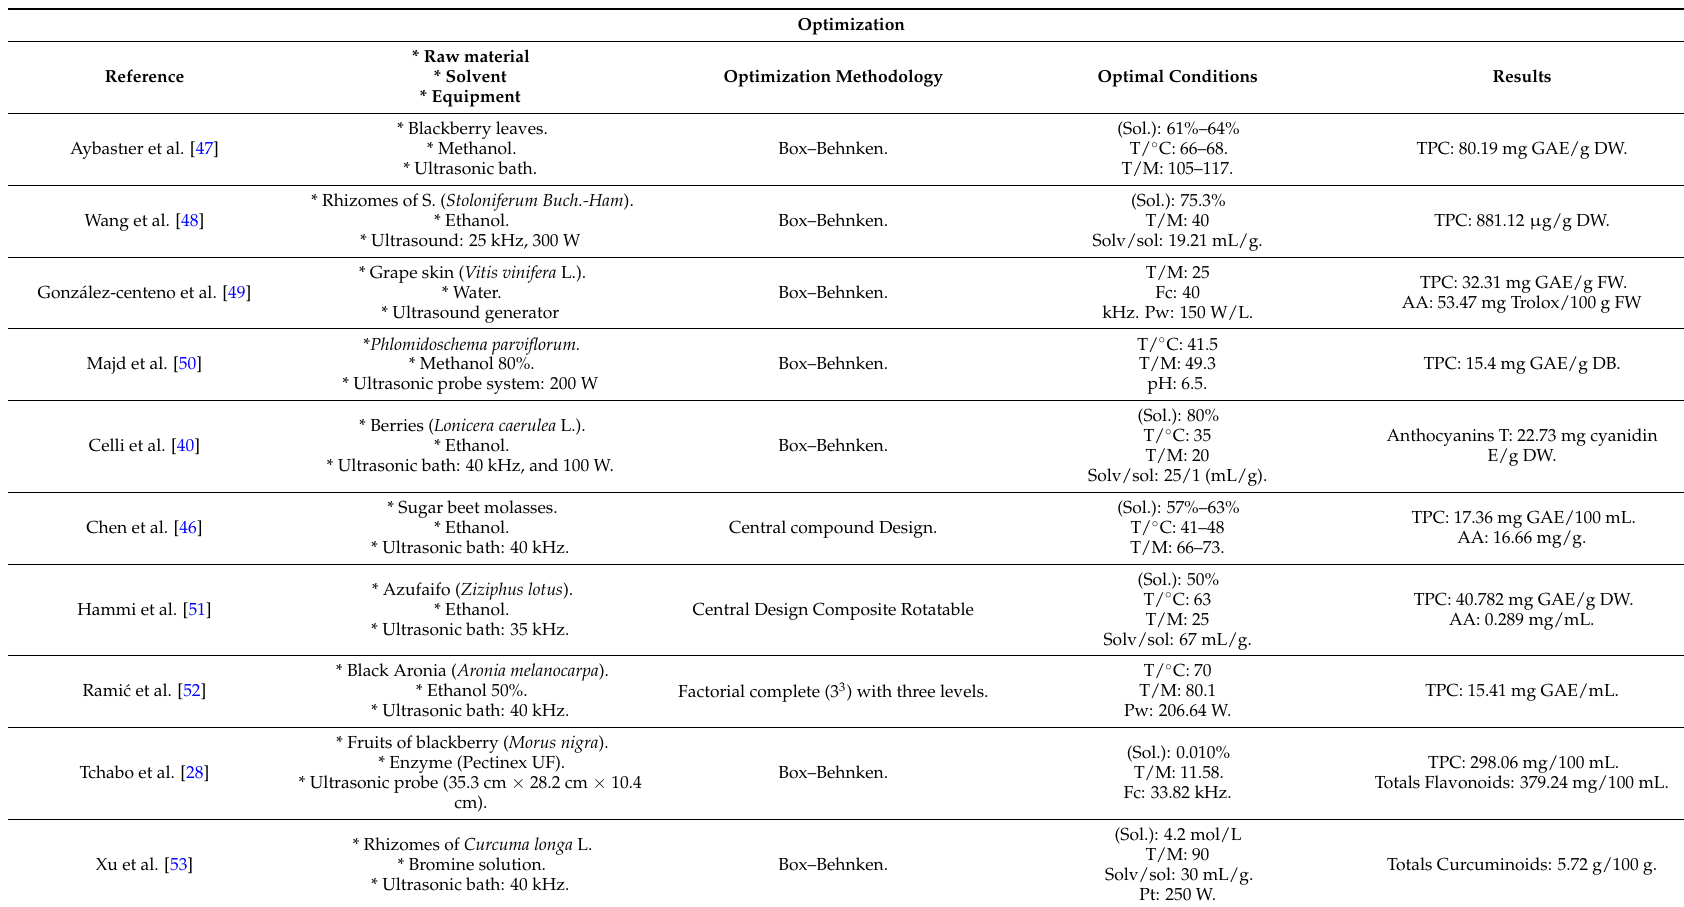
Table 4. Optimization studies reported for the production of phenolic compounds by